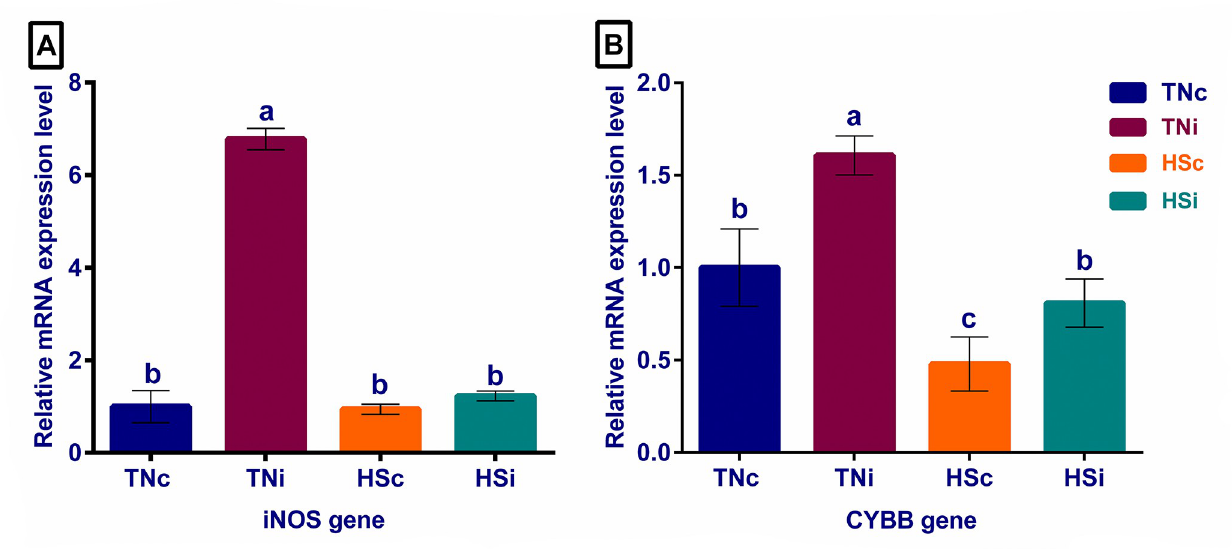
Fig 9. The mRNA expression of ileum tissue oxidative gene. The mRNA fold expression of ileum tissue oxidative genes iNOS (A) and CYBB (B) at 6 dpi of chickens infected with E . maxima and their uninfected controls that are raised in a thermoneutral or heat stress environment: TNc = thermoneutral control, TNi = thermoneutral infected, HSc = heat stress control, HSi = heat stress infected. Significant differences (p < 0.05) were depicted by different letters. The error bars represent the SEM.